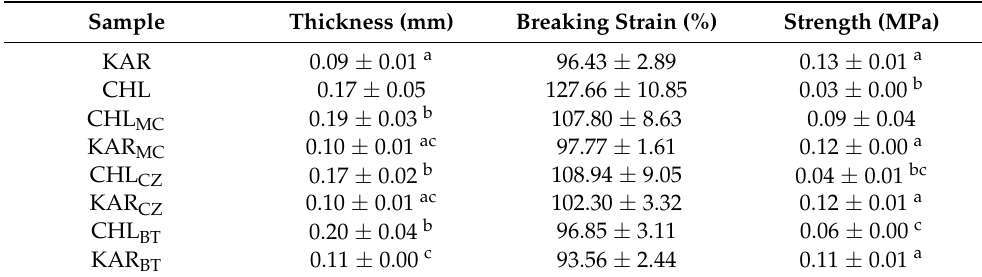
Table 3. Physical properties of prepared